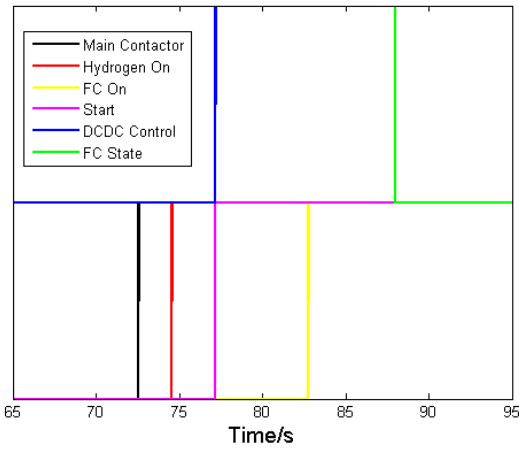
Figure 11. Signal change order during Start ‐ up process.